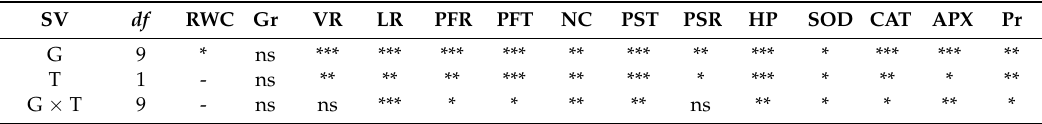
Table 2. Effects of Drought Treatment on Morphological, Physiological and Biochemical Traits of Ten Sesame Genotypes.